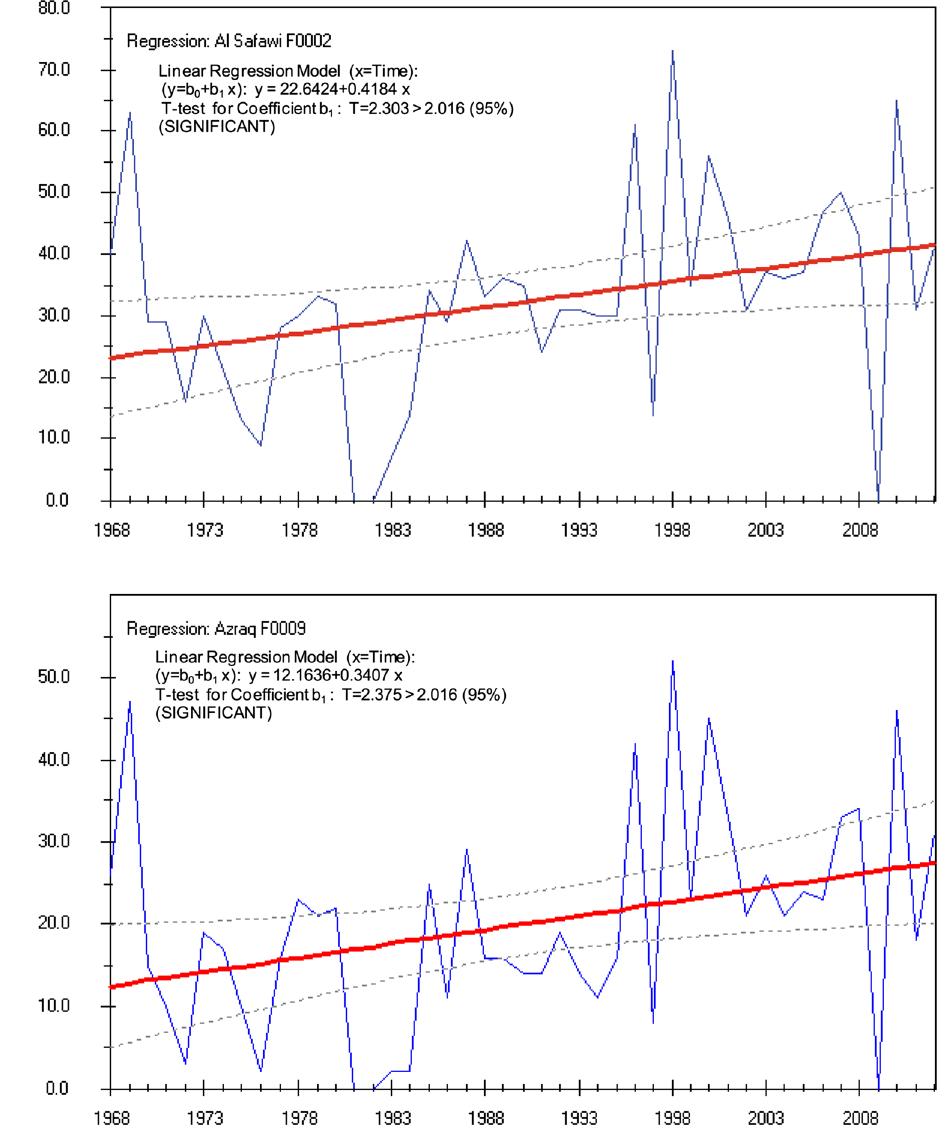
Fig. 6 Maximum temperature frequency (values exceeded 38 °C) in Al Safawi Station